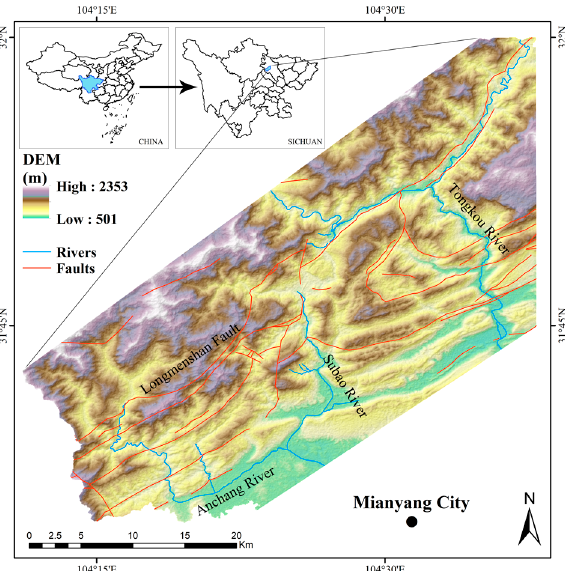
Figure 1. The DEM of the central Mianyang City of Sichuan, southwestern China.